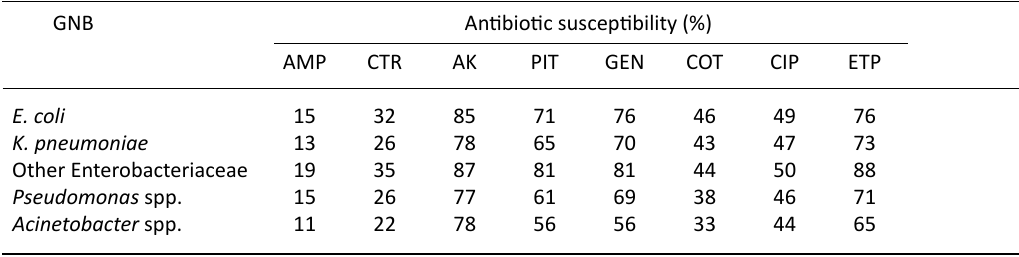
Table 2. The antibiotic susceptibility profile of Gram negative bacteria GNB